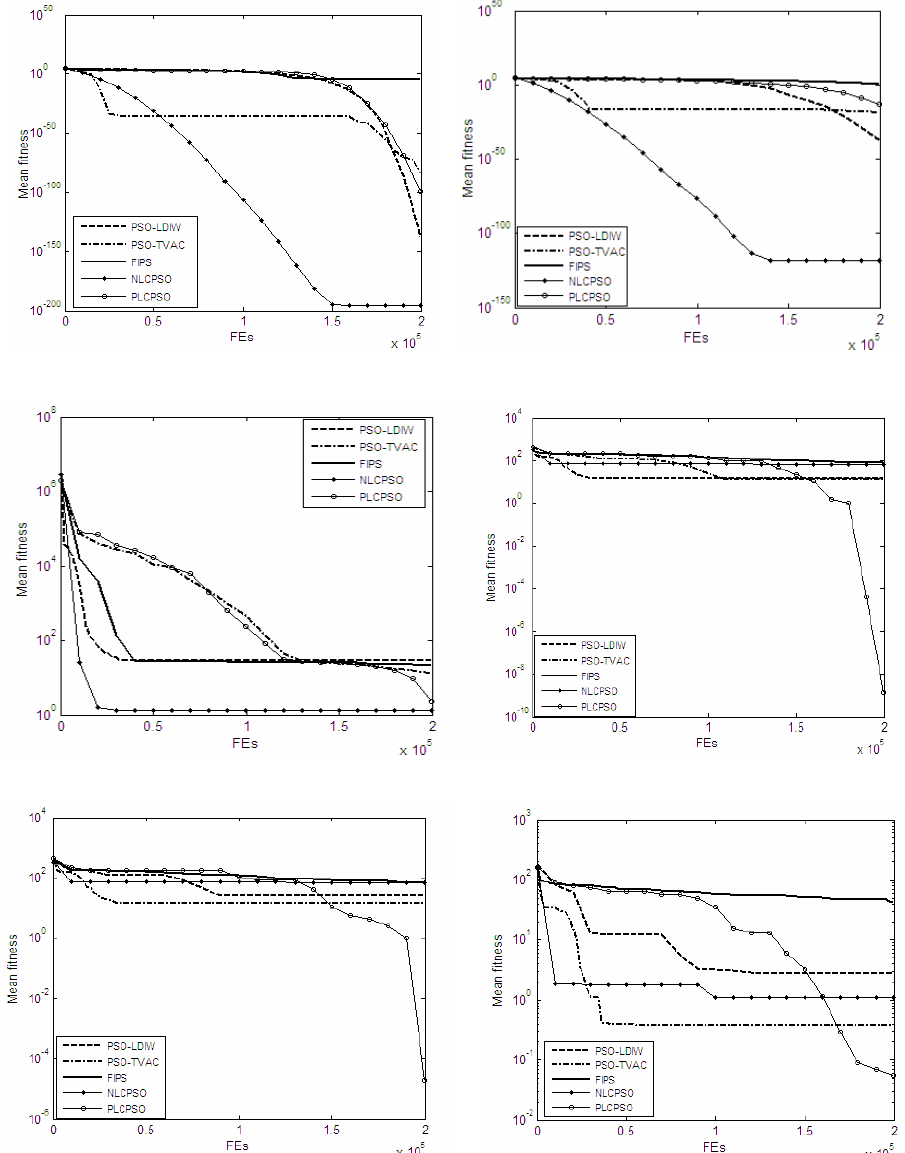
Fig.2 The convergence curve of test function for different function. (a) Sphere’s function. (b) Quadric’s function (c)Rosenbrock’s function (d) Rastrigin’s function (e) Noncontinuous Rastrigin’s function (f) Schaffer’s